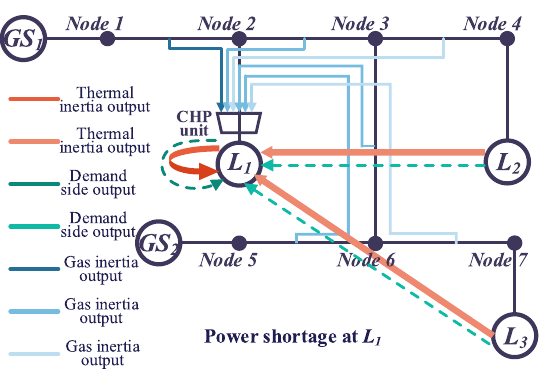
Fig. 5 Working mechanism of three output forms in the power support